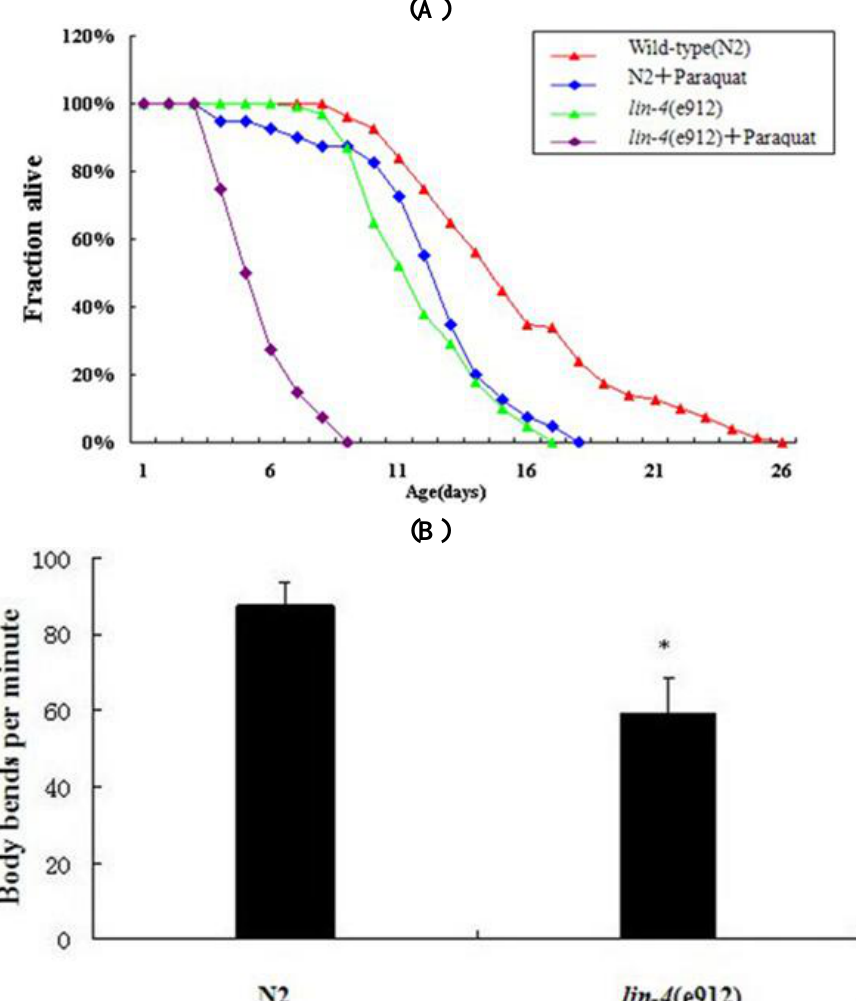
Figure 5. Effects of lin-4 mutation on life span and locomotion. ( A ) Red, survival